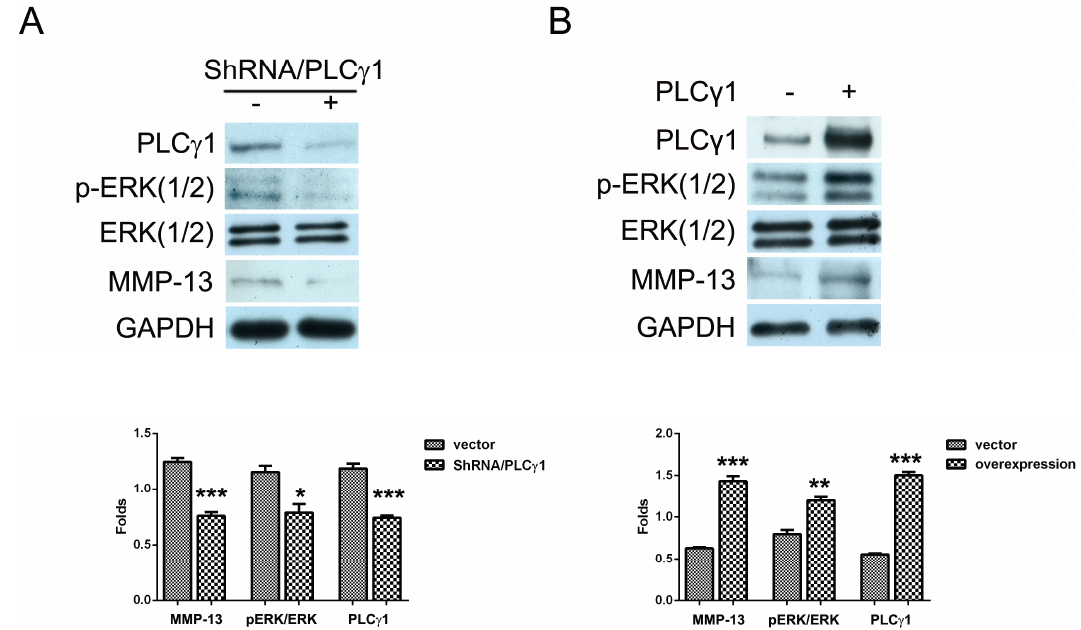
Figure 2. The effect of PLC γ 1 on the activation of ERK in human OA chondrocytes. ( A ) Cells were transfected with ShRNA/PLC γ 1 vector for seven days, and the levels of ERK(1/2), p-ERK(1/2) and MMP-13 were detected by Western blotting analysis using anti-ERK(1/2), p-ERK(1/2), MMP-13 and GAPDH antibodies; ( B ) Cells were